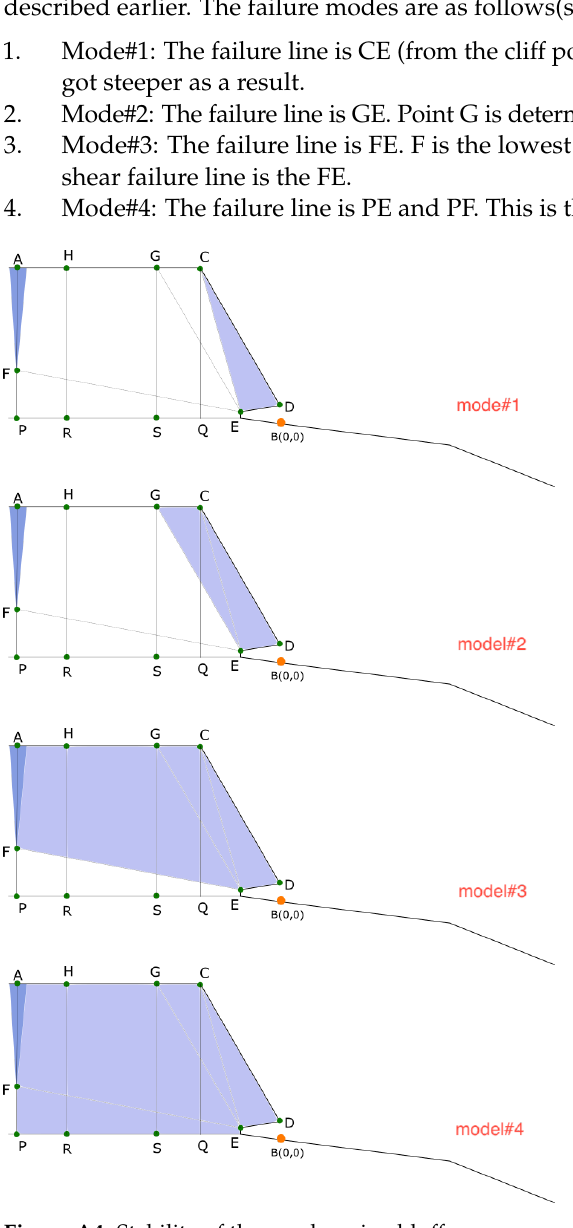
Figure A4. Stability of the overhanging bluffs.